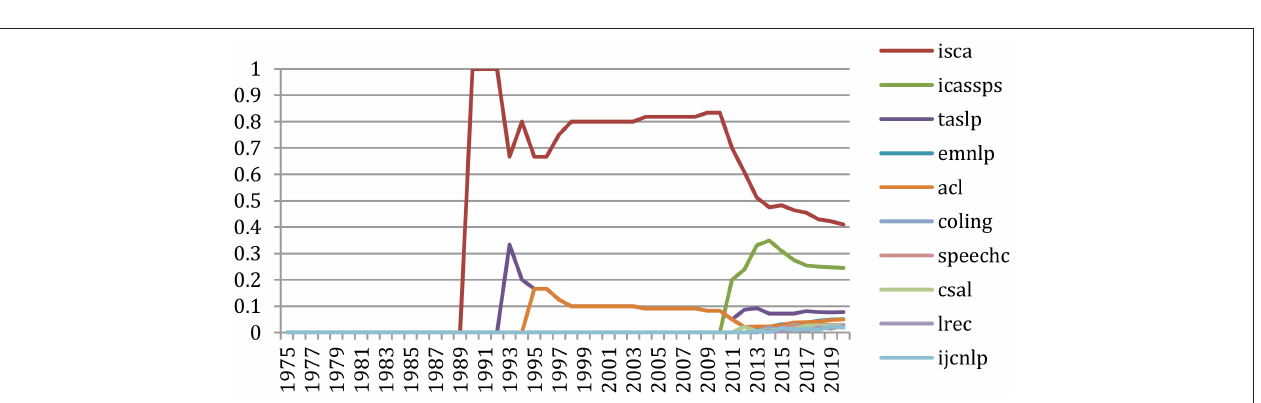
Frontiers in Research Metrics and Analytics | www.frontiersin.org 37 July 2022 | Volume 7 | Article